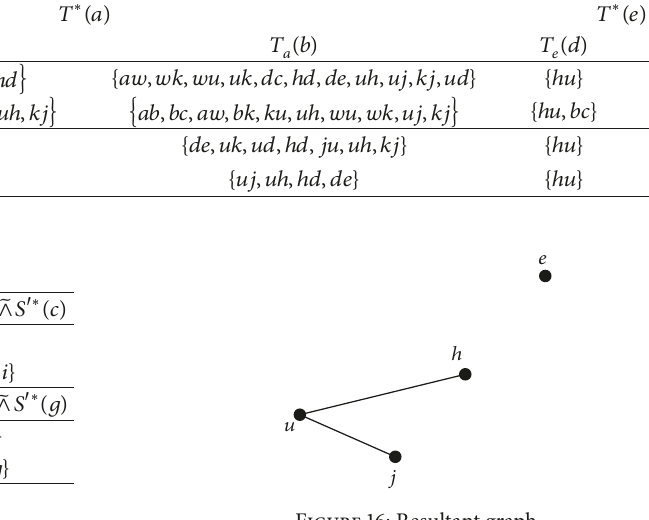
Figure 16: Resultant